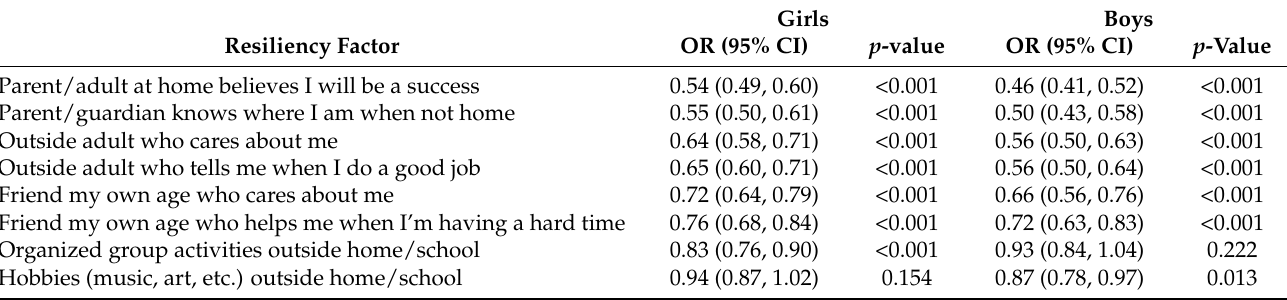
Table 2. Probability ratio associated with factors hypothesized to be protective against past-year suicide attempts among Hispanic schoolchildren, by sex, 2019 NM